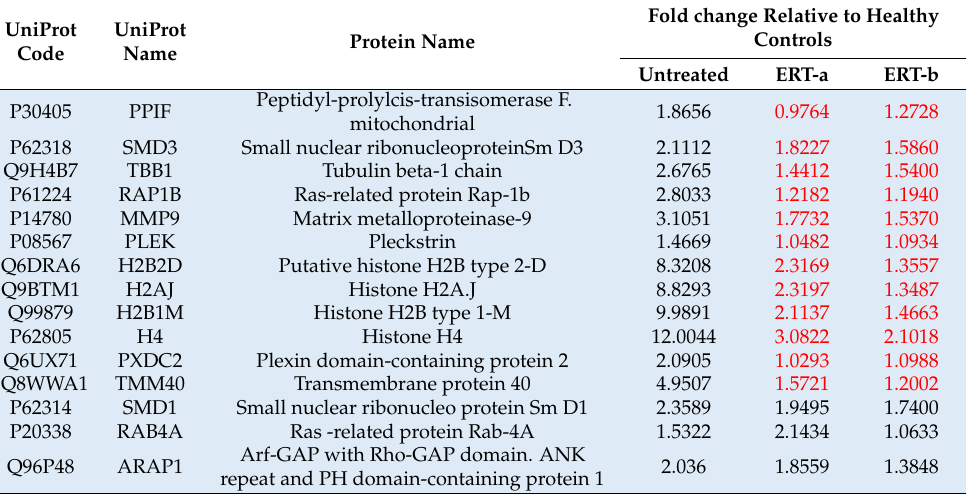
Table 5. Proteins upregulated in untreated and ERT-treated MPS IVA patients relative to healthy controls. Proteins considered dysregulated are those with a p -value < 0.05 and a fold change (FC) >